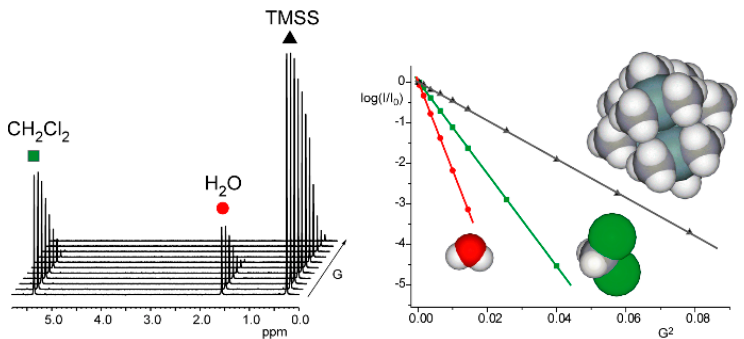
Figure 4. Reproduced from ref. [73]. Left: A series of 1D nuclear magnetic resonance (NMR) spectra recorded at different G values. Right: Plot of the log( I / I 0 ), where I and I 0 are the intensities of the signals in the presence and in the absence of G , respectively, vs. G 2 . Note the inverse proportionality between the slope of the fitting line and the molecular size.